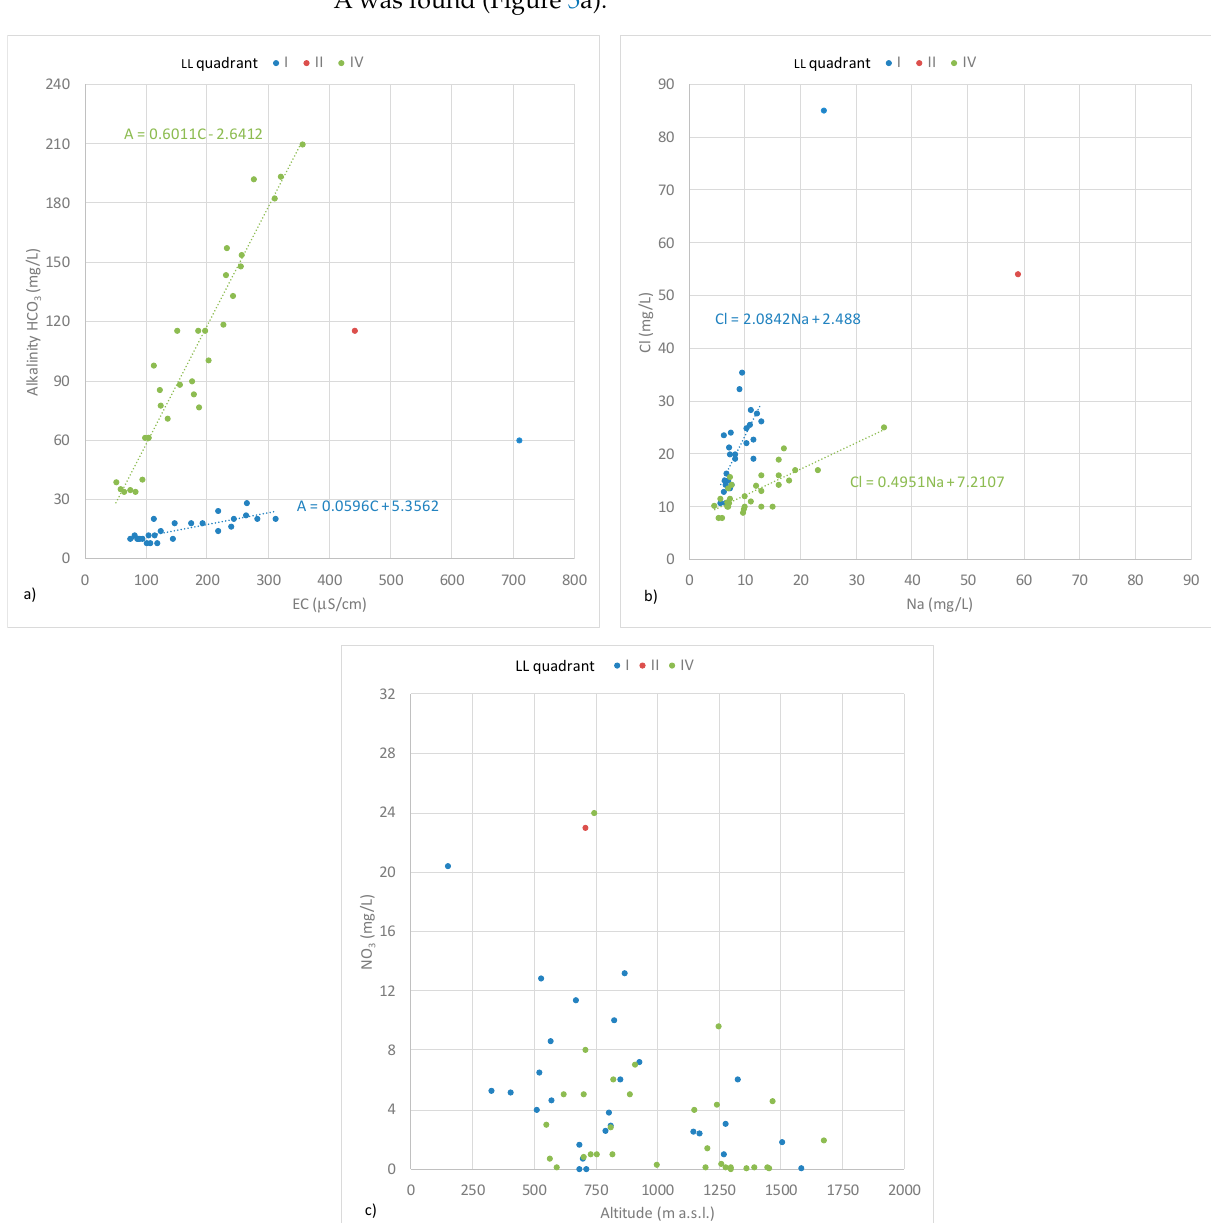
Figure 4. Langelier–Ludwig (LL) diagram ( a ) and classification of the spring waters (LL quadrants) according to geology ( b ).